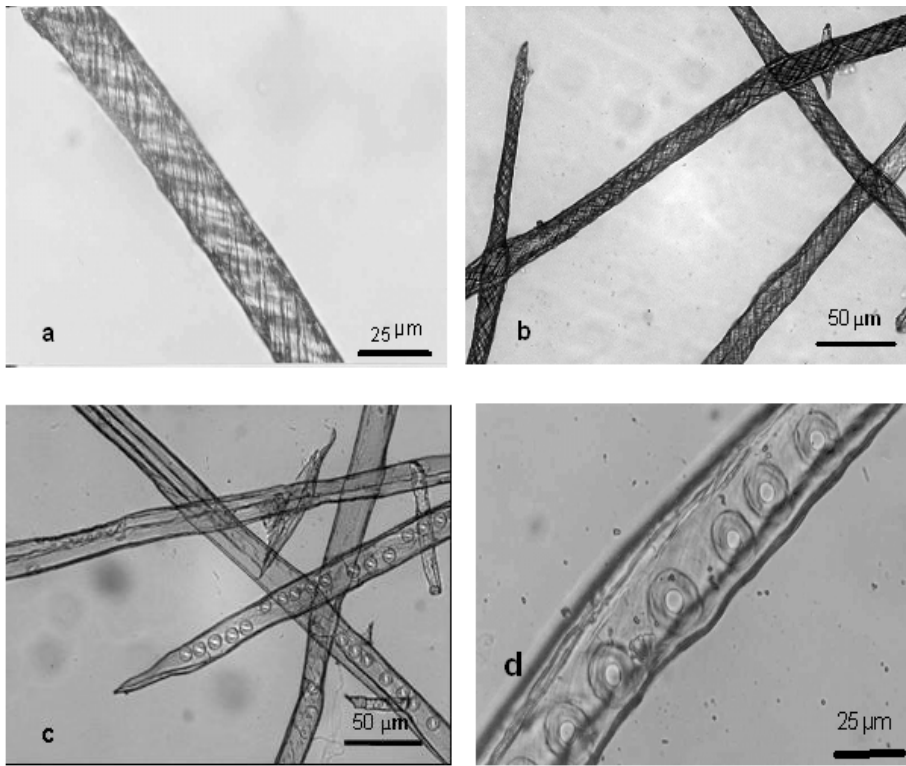
Fig. 6. Light microscope images of macerated longitudinal tracheids from compression wood (a and b) and opposite wood (c and d) of Picea abies . Bordered pits on the compression wood tracheids are